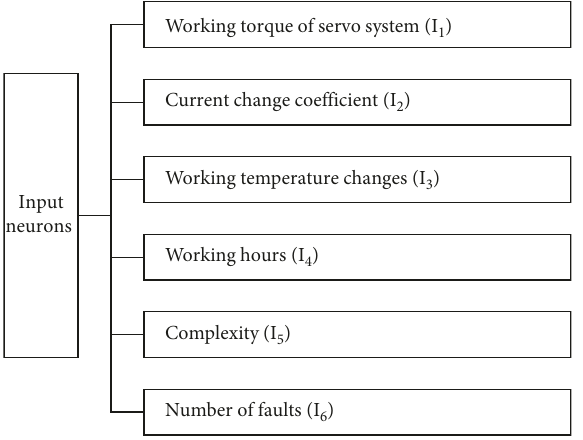
Figure 2: Neural network input neurons. Table 1: Complexity Classification of the servo